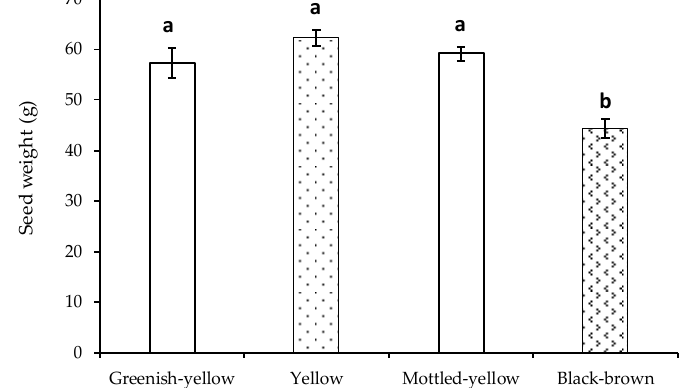
Figure 3. Dry seed weight (100 seeds) at four jatropha fruit ripening stages. Vertical bars indicate the standard error. Different letters indicate a significant difference.